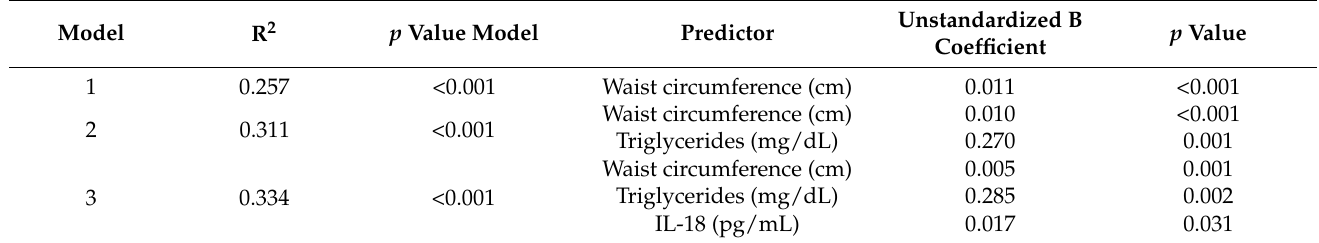
Table 4. Multiple linear regression model indicating predictors of HOMA-IR.